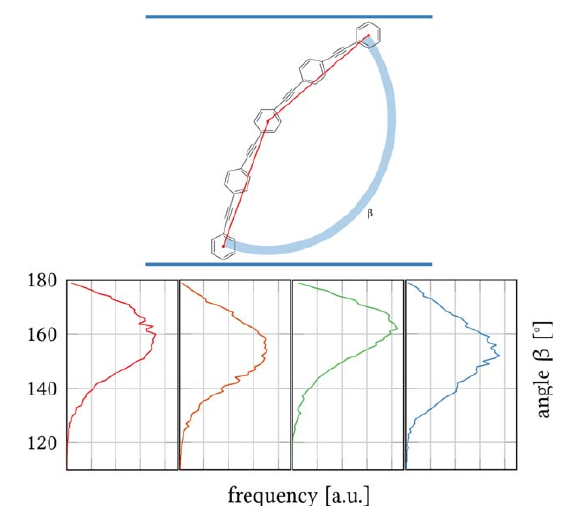
Figure 8. Top: Definition of the backbone bending angle β . Bottom: Distribution functions (histogram renormalized with 1/sin β ) for each of the four